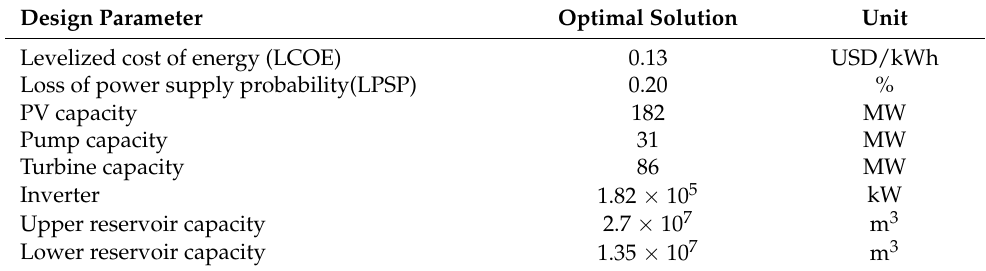
Table 4. Selected design values.